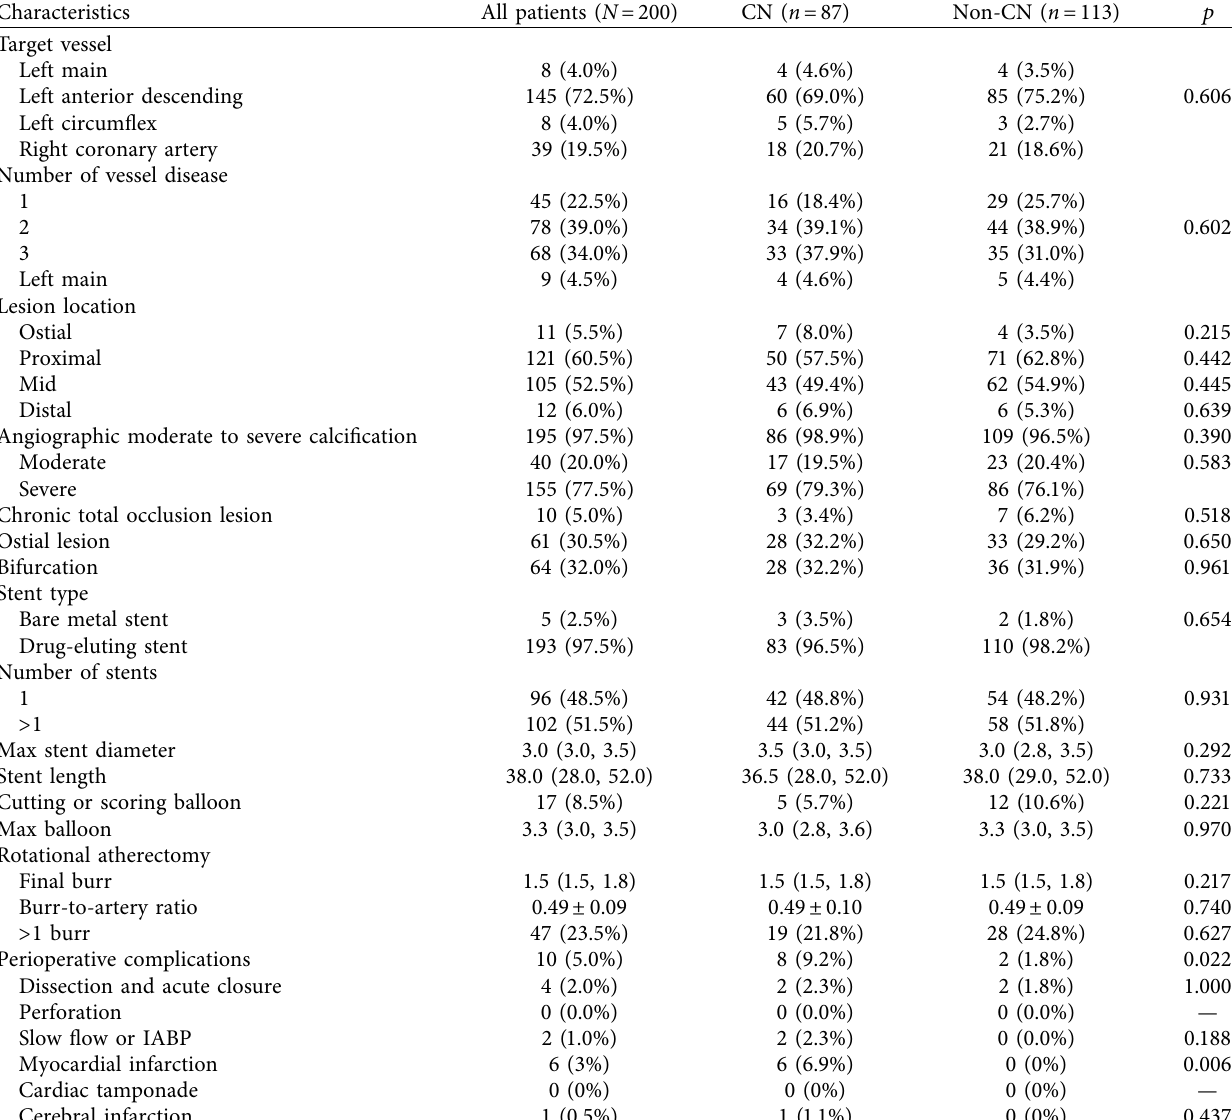
Table 2: Lesion and procedure characteristics of all patients and comparison between those with and without calcifed nodule. Characteristics